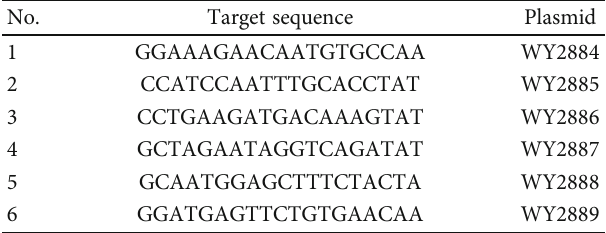
Table 2: Sema3A target screening